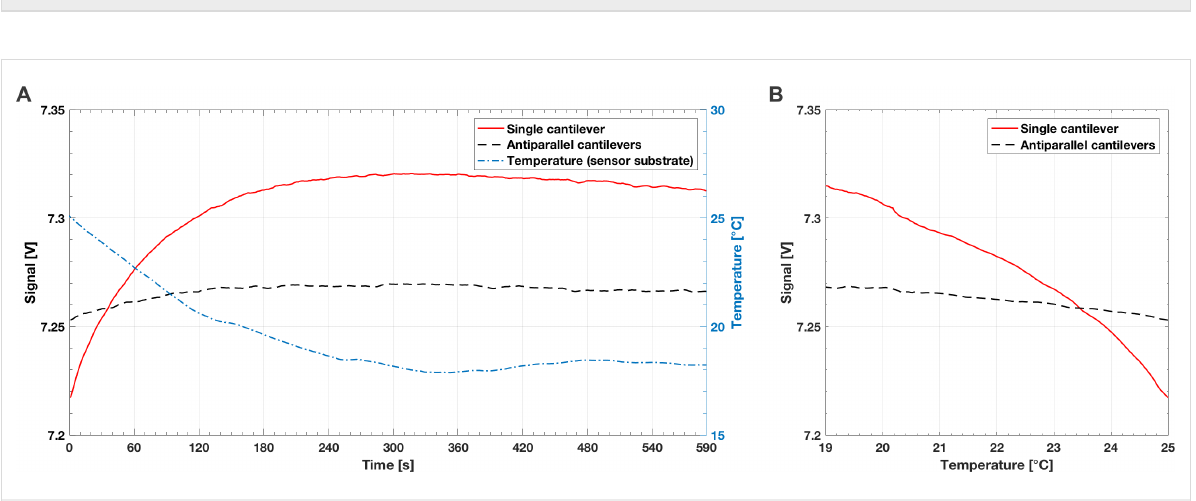
Figure 8: (A) Influence of temperature changes on micro strain gauges as a function of time. The offset voltage of the single cantilever drifted around 100 mV, while the antiparallel cantilevers drifted only around 15 mV. (B) Temperature offset curve for the single and antiparallel artificial hair sensors.